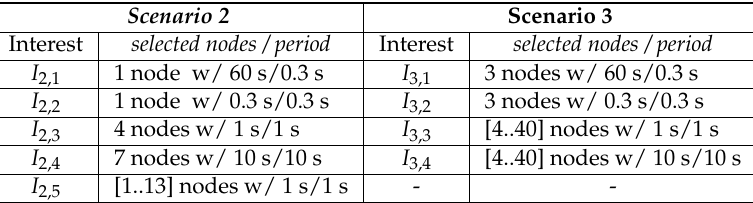
Table 3. Scenarios 2 and 3 Interest message base configurations.